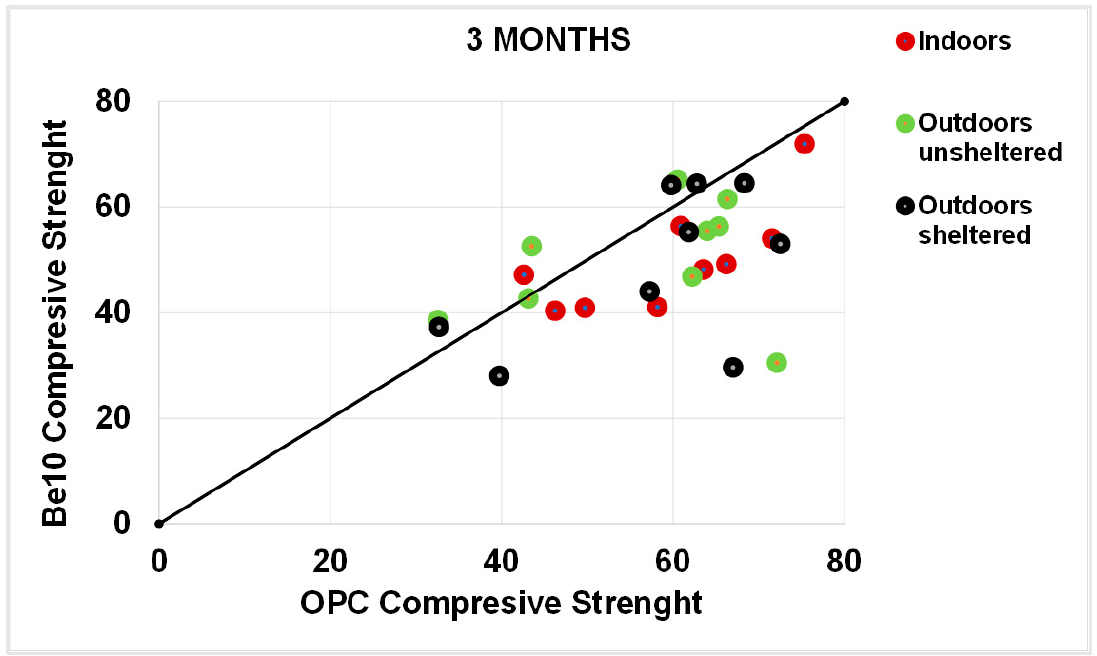
Figure 14. Three-month compressive strength: OPC vs.